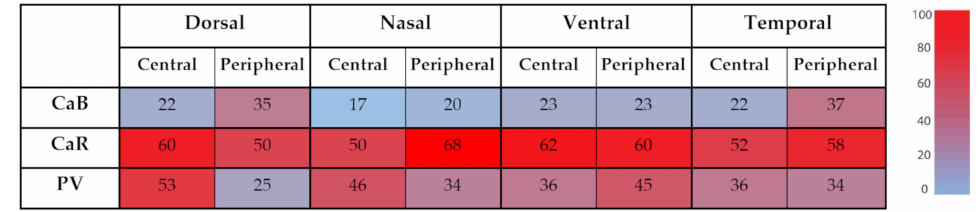
Table 2. Relative frequency of given protein-expressing cells (given as a percentage of all RGCs in the corresponding retinal